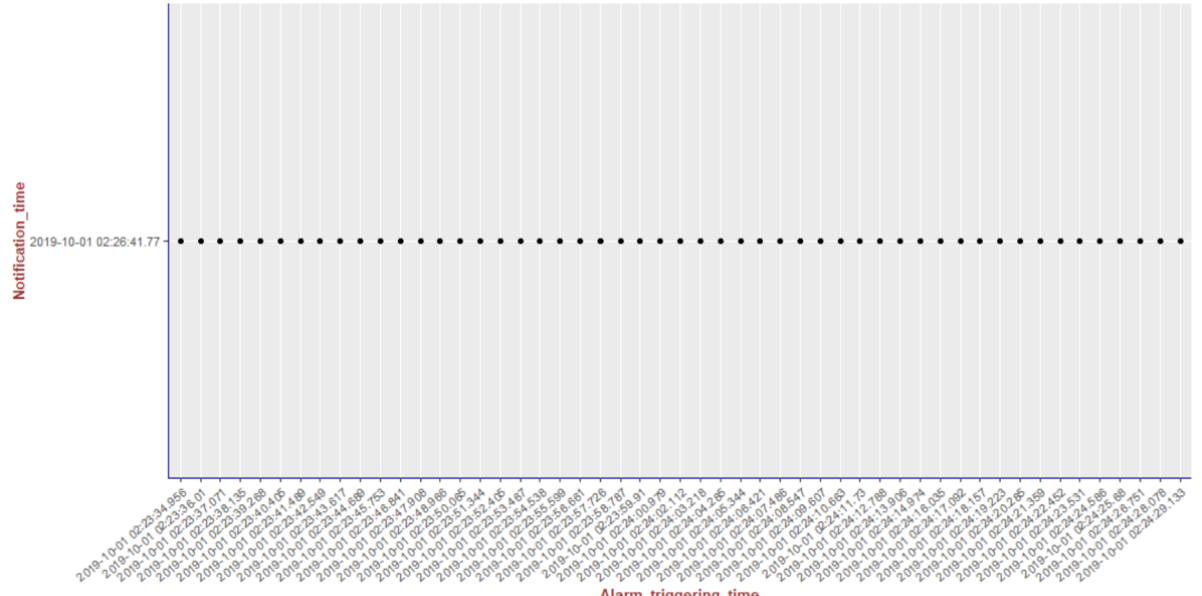
Figure 12. Illustration of the results of the alarm triggering and delivery processes related to the patient monitored in our experiment 5